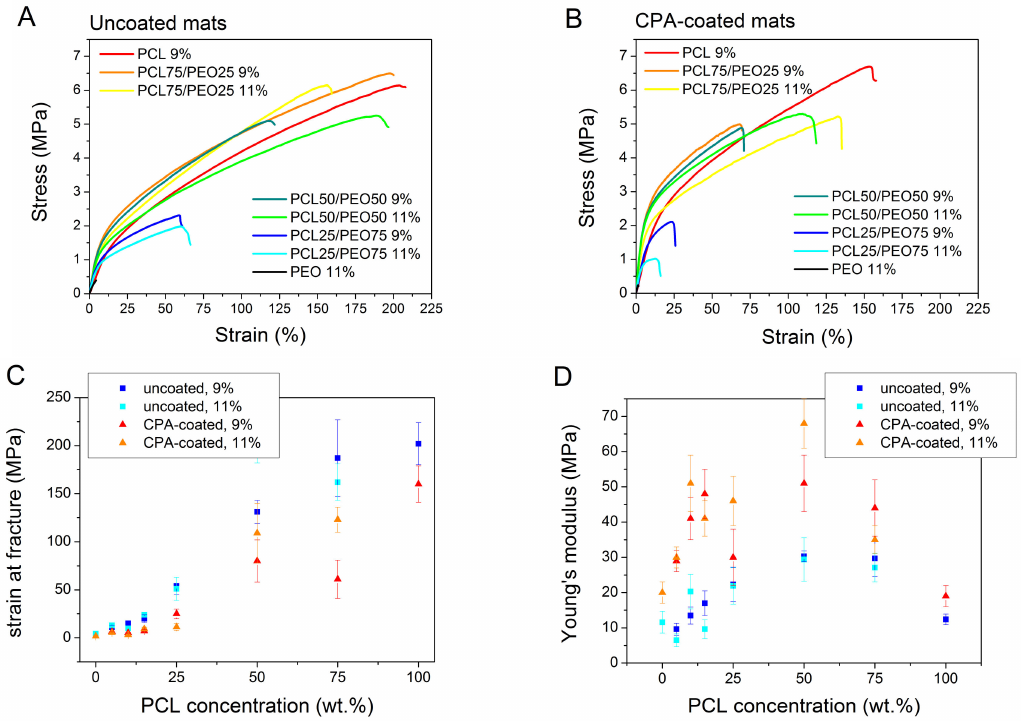
Figure 6. Stress–strain curves showing tensile properties of ( A ) uncoated and ( B ) CPA-coated nanofibrous mats. The polymer concentration (wt.%) and the composition of the polymer mixture in the electrospinning solution are given in the figure captions. Stress–strain curves for high concentration PEO mixtures are shown in the Supporting Information Figure S4. Graphs ( C ) and ( D ) show dependencies of the mechanical properties calculated from the stress–strain curves on the weight concentration of